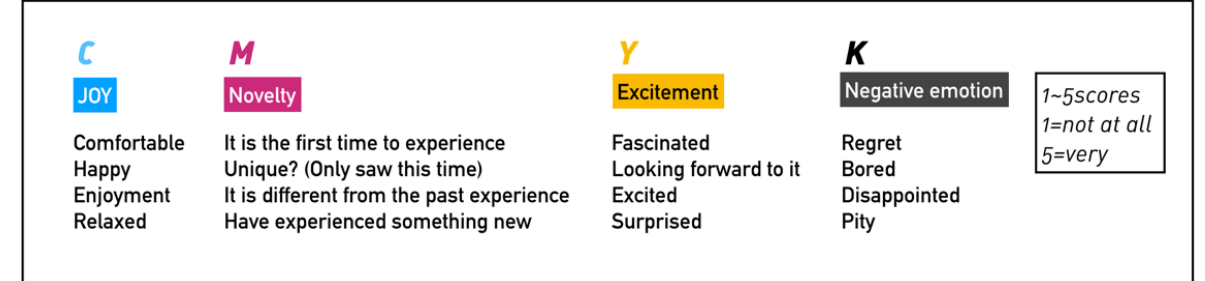
Figure 6. Evaluation dimensions of emotion in questionnaire.